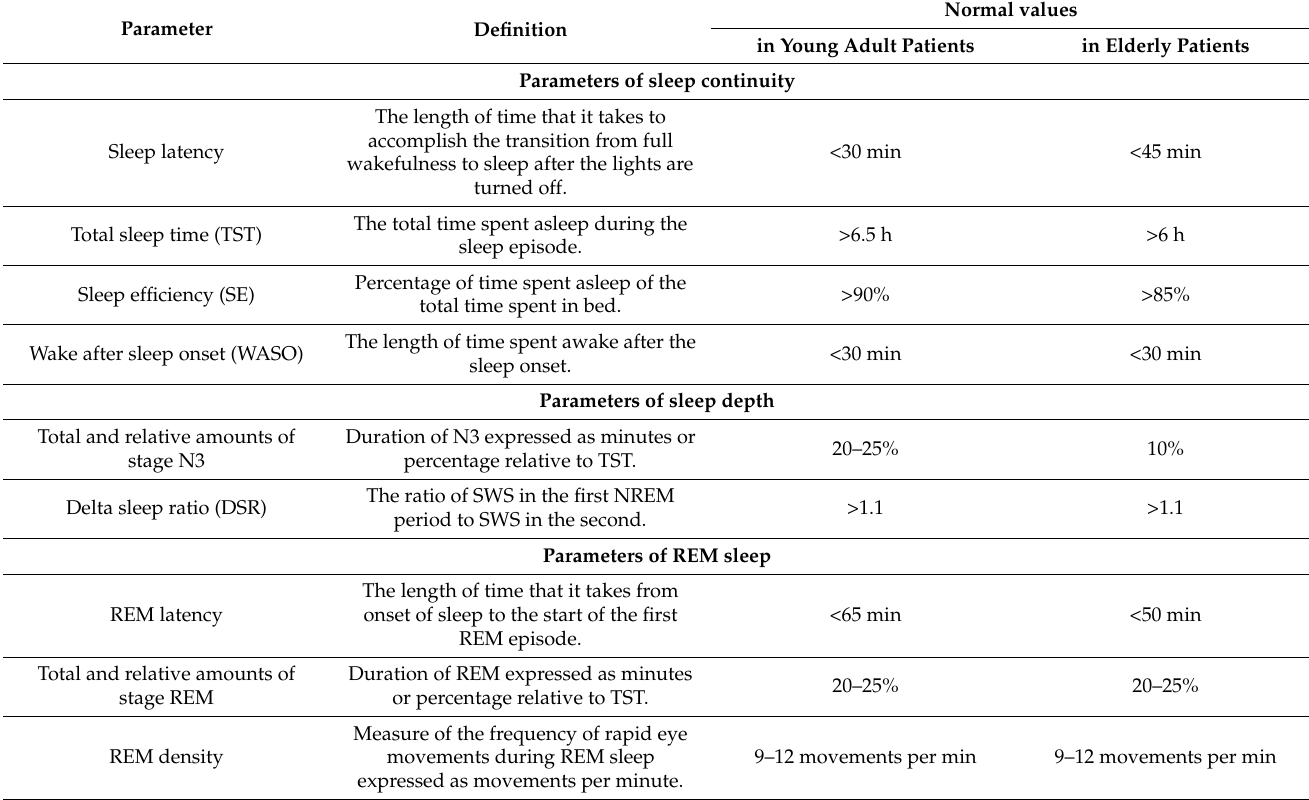
Table 2. Definitions of sleep parameters and relating age